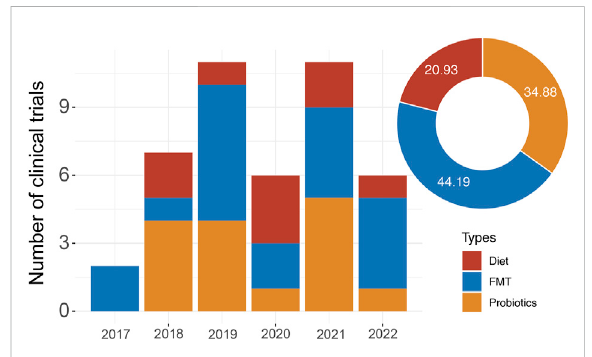
FIGURE 1 Theclinicaltriallandscapeofimmunotherapyincombination with microbiota-based therapy. The graph shows the number of combination trials starting each year since 2017. The pie chart shows the proportion of different microbiota-based